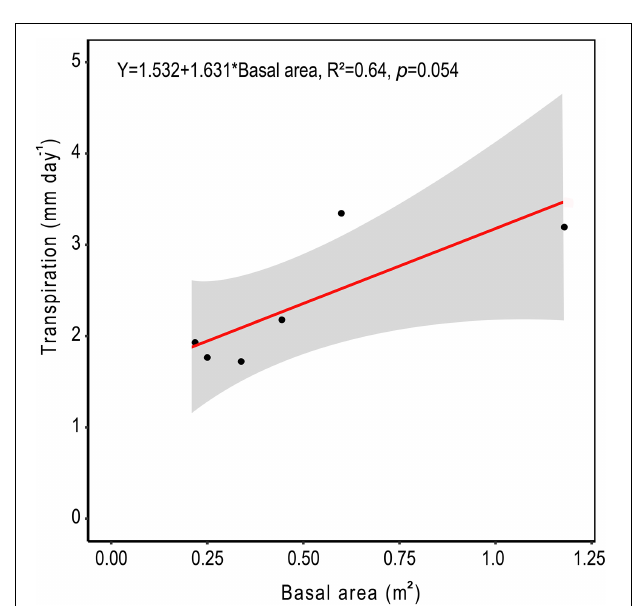
We found a positive relationship between tree size and water use across the entire range of sampled sap flow trees, similar to that reported in other tropical forest studies [e.g.,